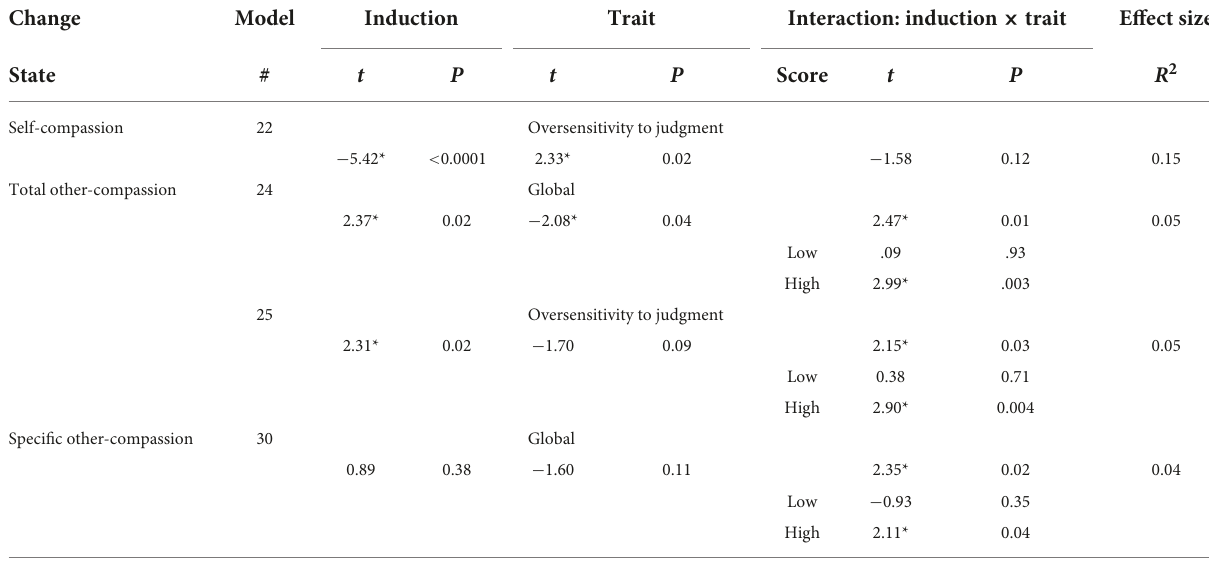
TABLE 3 Significant moderation regression analyses for vulnerable narcissistic